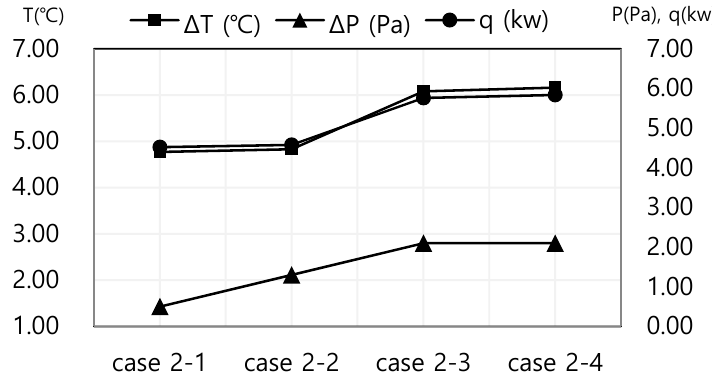
Figure 8. Changes in temperature, pressure, and thermal capacity with the internal form change.